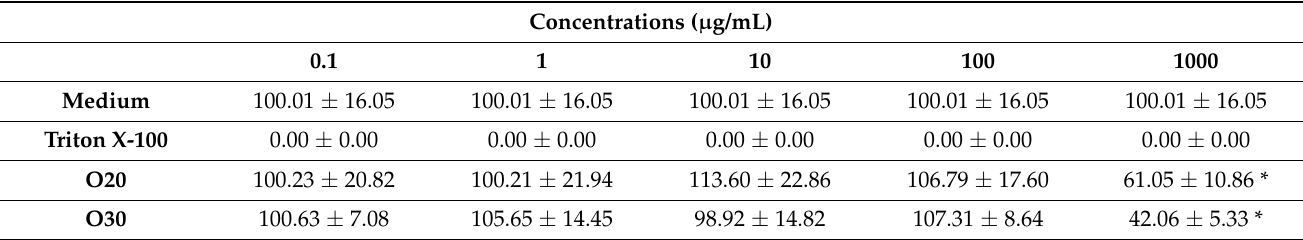
Table 4. Effects of exposure to O20 and O30 extracts on the viability of keratinocytes at different concentrations, as measured by the MTT